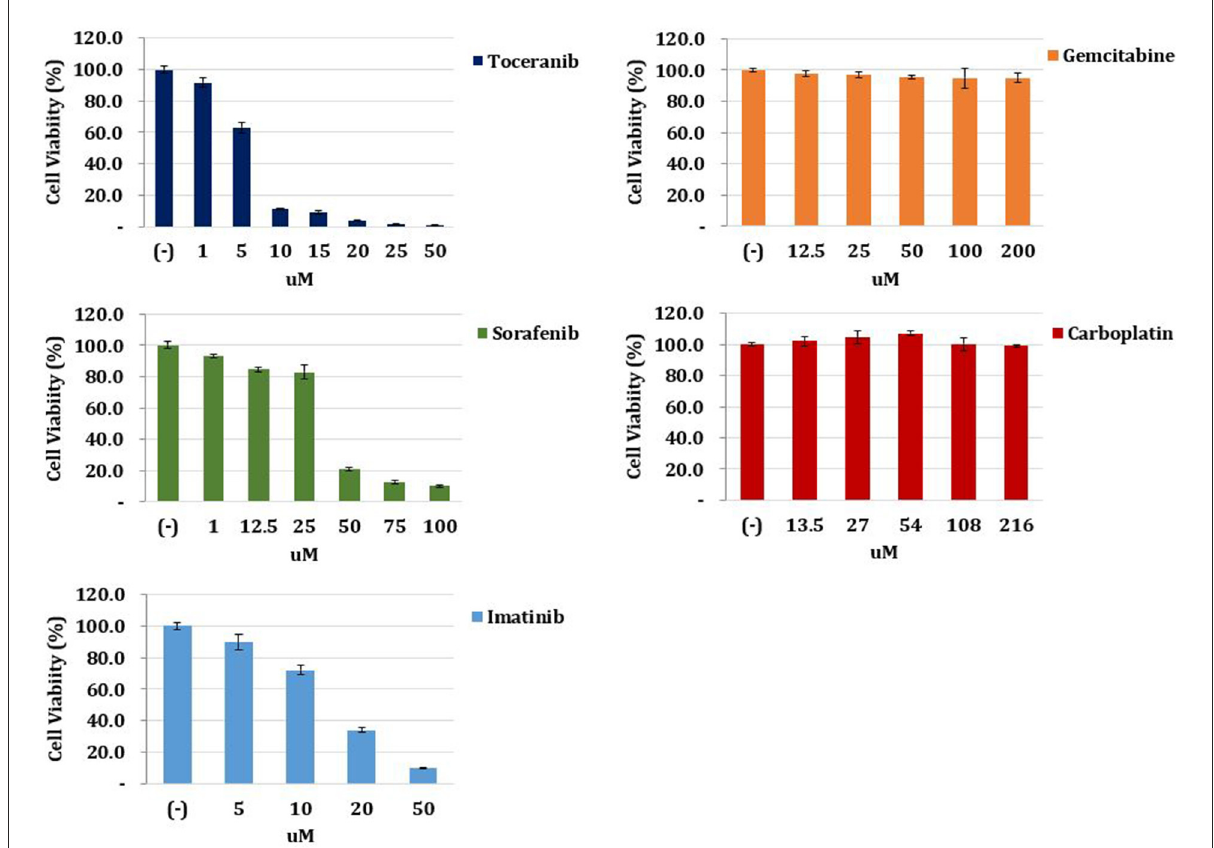
FIGURE3 Anticancer drug response prediction test. The tumor tissue obtained from the patient was harvested, lysed, and filtered. The tumor sample was dissociated into single cells and cultured in medium. Cells were seeded and incubated in 96-well plates, and the medium was replaced with that containing gradient doses of chemotherapy drugs. After 24h, cell viability was examined. The result revealed that toceranib had the best cancer cell-killing effect among gemcitabine, carboplatin, toceranib, sorafenib, and imatinib.